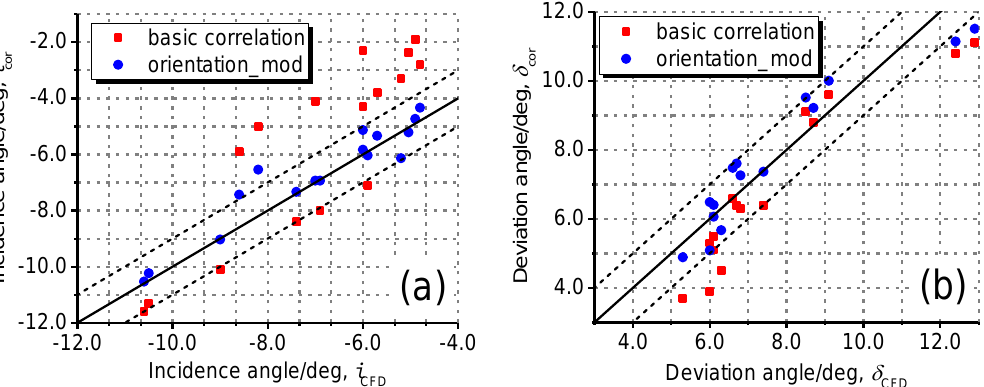
Figure 14. Comparisons between the results obtained from basic and modified correlations of ( a ) incidence and ( b ) deviation angles for orientation parameter correction.